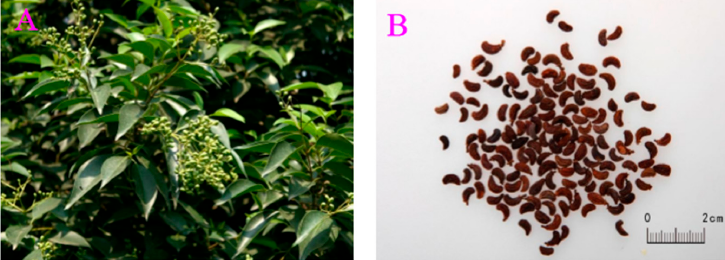
Figure 1. Representative images of Ligustrum lucidum Ait ( A ); and Fructus Ligustri Lucidi ( B ); which are used for isolating constituents for the treatment of osteoporosis. Pictures were kindly provided by